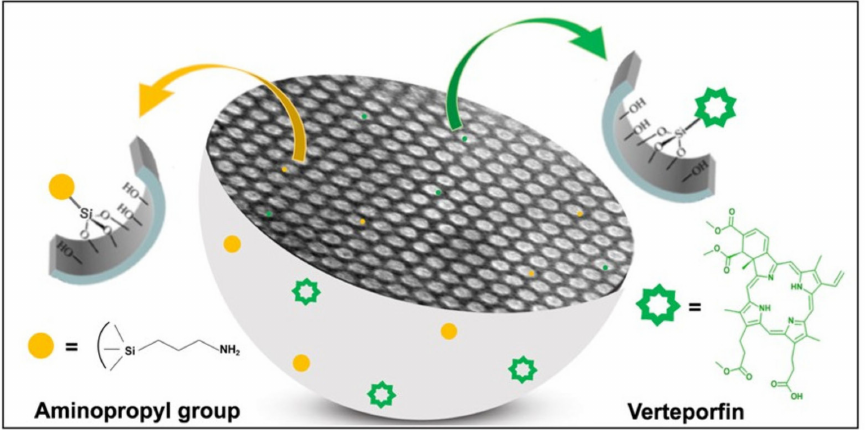
Figure 1. Pictorial representation of amino-modified mesoporous silica nanoparticles grafted with